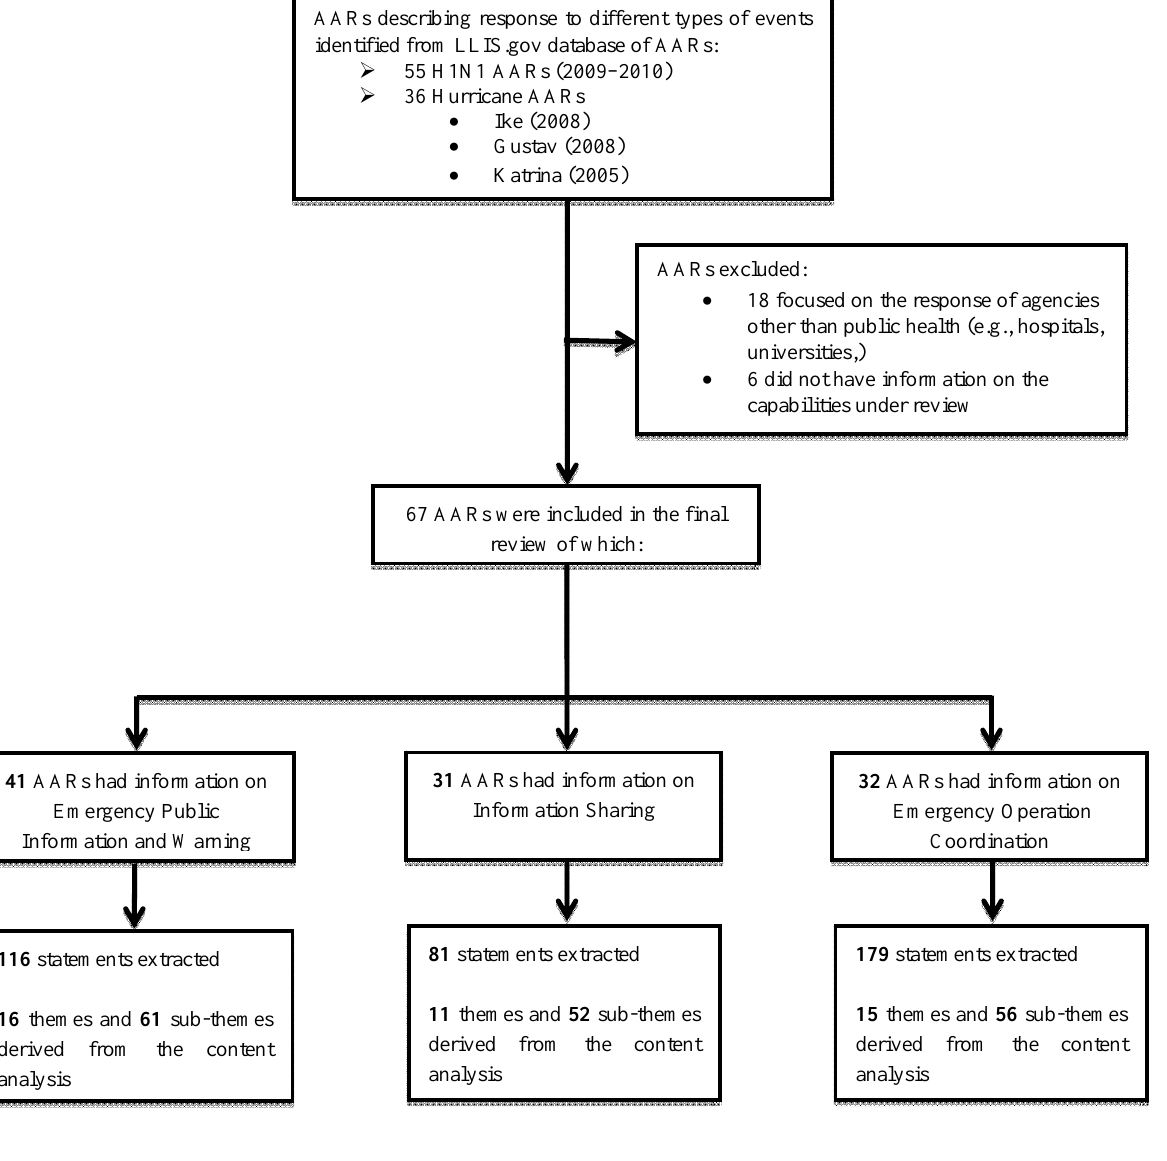
Figure 1. Flowchart showing the AARs review